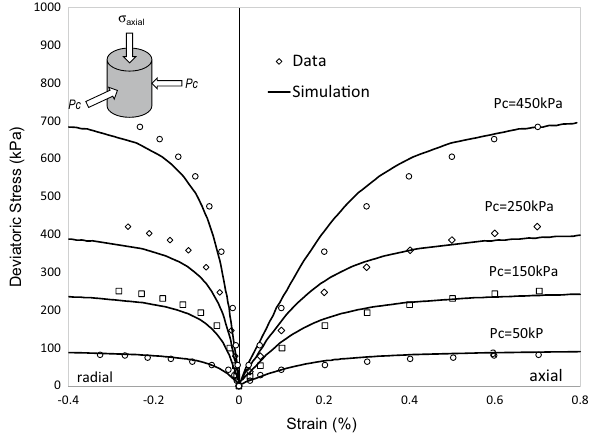
Fig. 9 Comparison of numerical simulations and experimental data of triaxial compression tests with confining pressures of 50, 150, 250, and 450 kPa (oil-bearing sand)